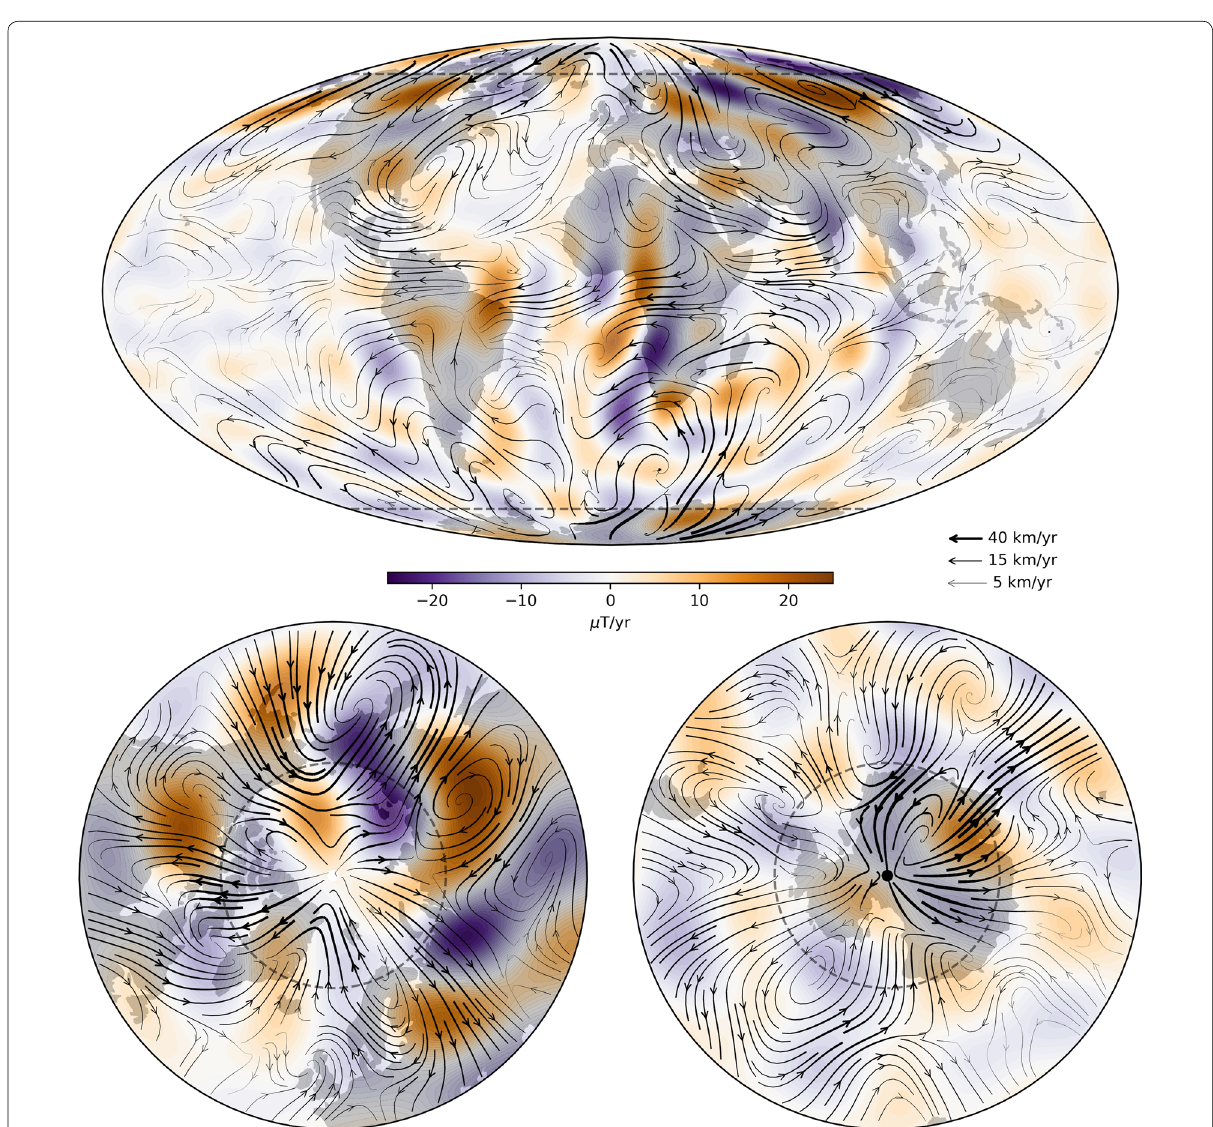
Fig. 6 Instantaneous radial SV ( ˙ B r ) at the CMB and horizontal flow ( (cid:31) U H ) for the 2020 analysis of our assimilation. The top panel shows a Mollweide projection while the bottom panels display views on the north and south poles. The SV is truncated at ℓ = 18 , the maximum Kalmag degree assimilated in our scheme. The dashed circle represents the